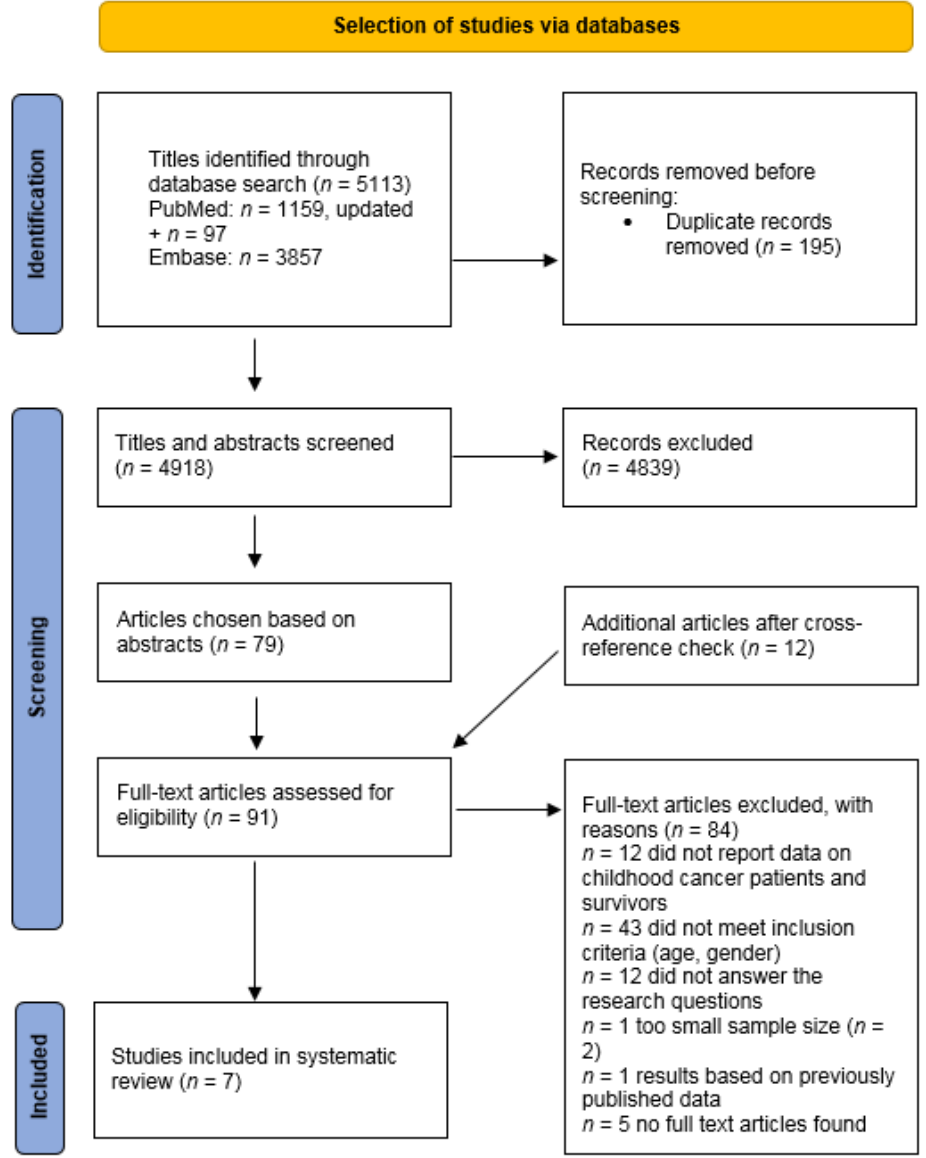
Figure 1. PRISMA study flow diagram of the search strategy in the PubMed and Embase Database, updated on 4 March 2023 [30].